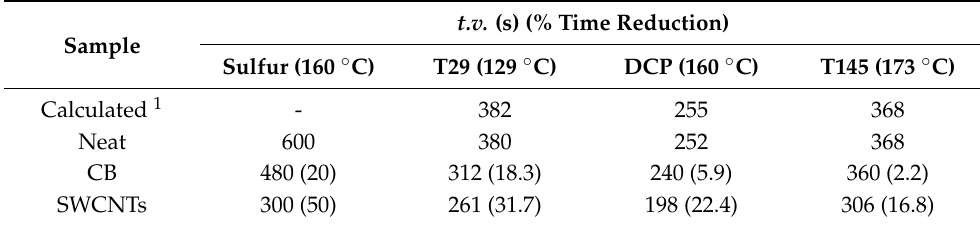
Table 4. Vulcanization times ( t.v. ) obtained for the vulcanization of NR